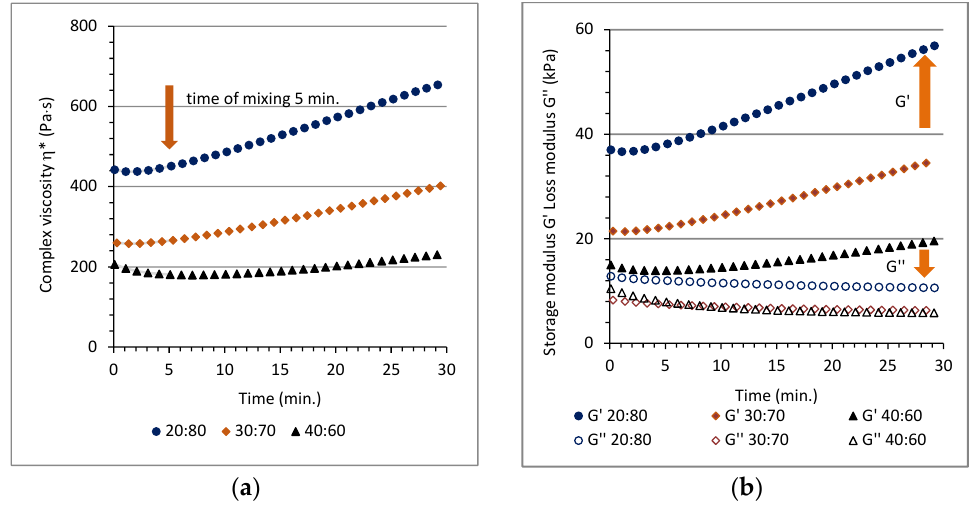
Figure 1. The complex viscosity η * as a function of time at processing temperature 160 °C at constant strain and angular frequency, equivalent of 1 s −1 oscillation strain rate ( a ). The storage modulus G’ and loss modulus G’’ as a function of time at processing temperature of 160 °C ( b ).